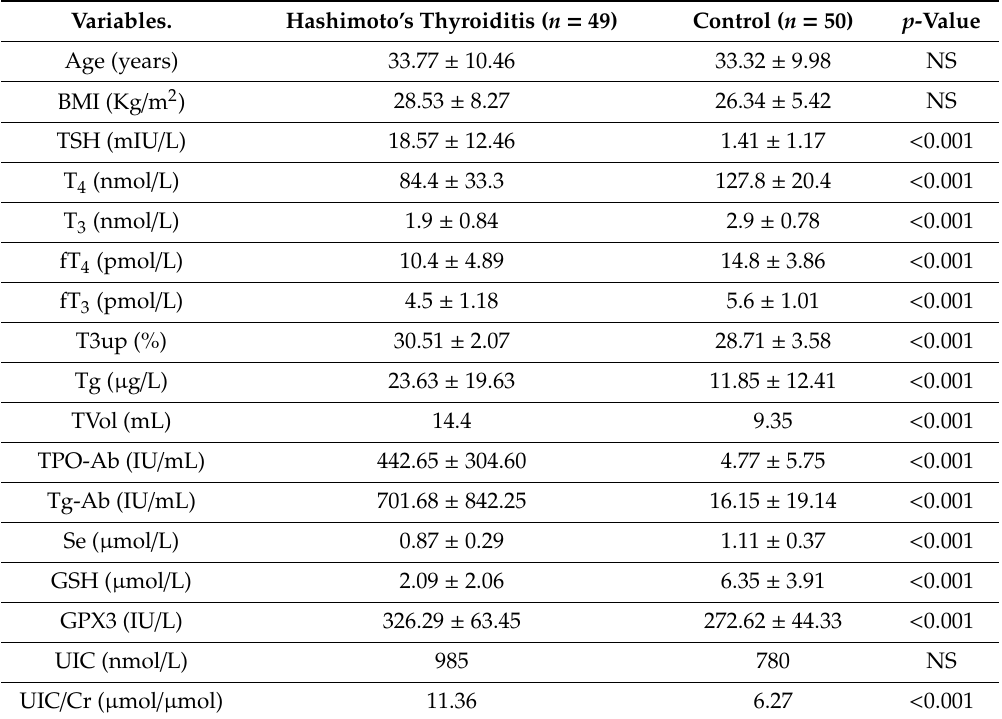
Table 1. Clinical- and biochemical characteristics in new case Hashimoto patients with hypoechogenic thyroid and matched